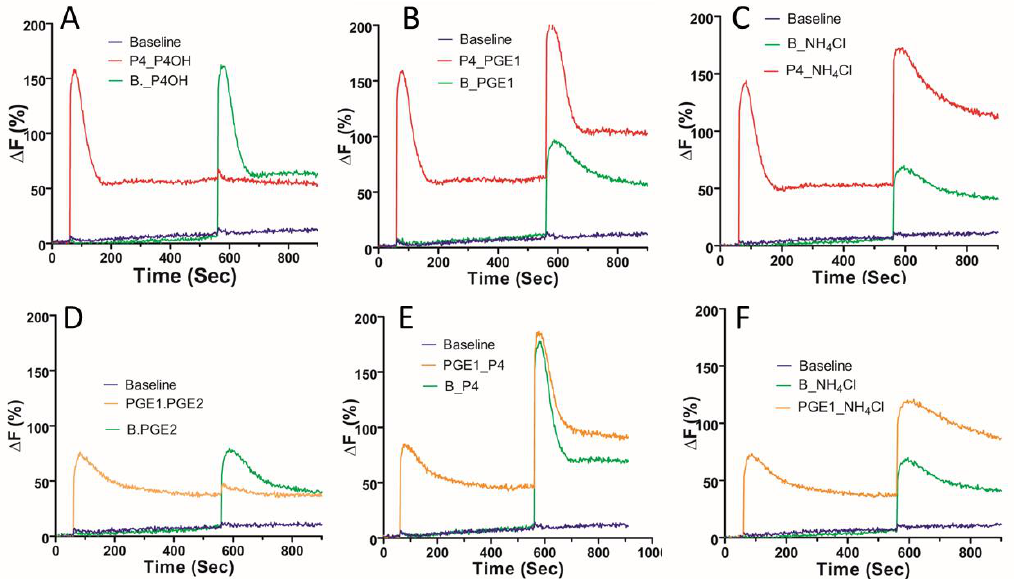
Figure 8. Examination of agonist cross-desensitization. Population mean [Ca 2+ ]i traces ( n = 5) showing initial agonist addition of either a saturating concentration of 10 µ M progesterone (P4) ( A – C ) or 5 µ M prostaglandin E1 (PGE1) ( D – F ), followed by the second agonist addition (17-OH progesterone (P4OH); prostaglandin E2 (PGE2)). A baseline control (shown in blue) was included in each experiment (sEBBS, represented as “B”). Addition of time control for the second agonist is shown in green. Cross-desensitisation experiments are shown in red (top panels) and orange (bottom panels). ∆ F (%) is the percentage change in intensity (see methods).